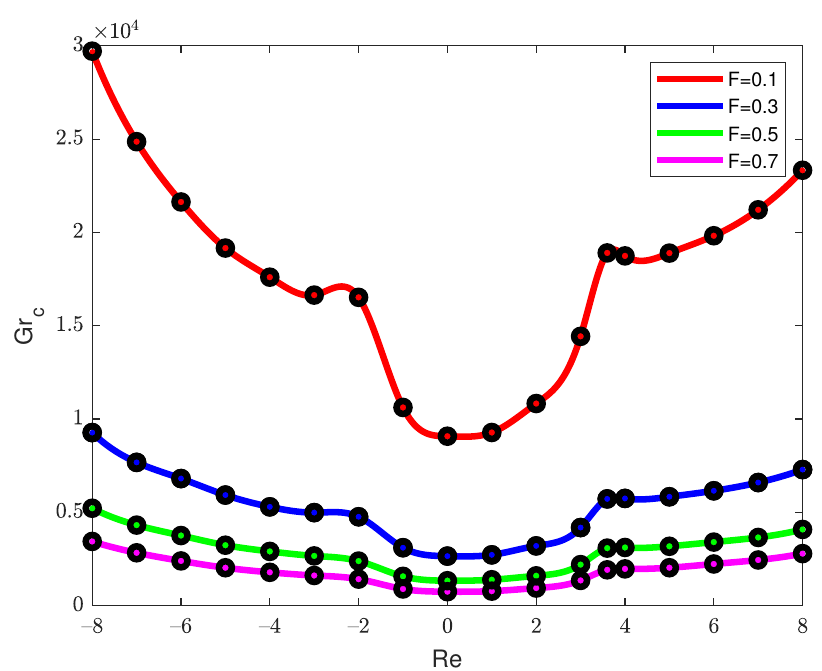
Figure 9. Critical Grashof numbers versus Re in the range − 8 ≤ Re ≤ 8 for different values of F